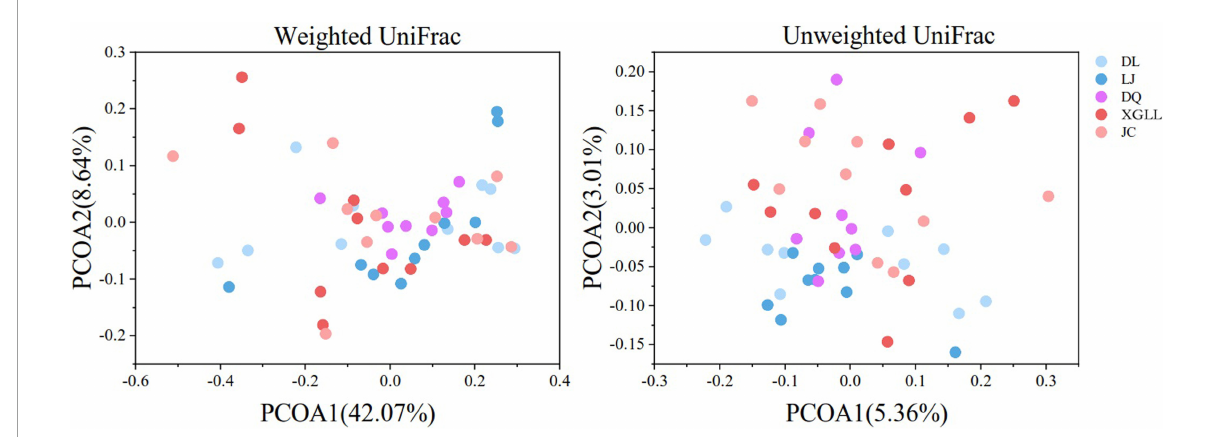
FIGURE4 β diversity of feces in Eothenomys miletus in different regions.